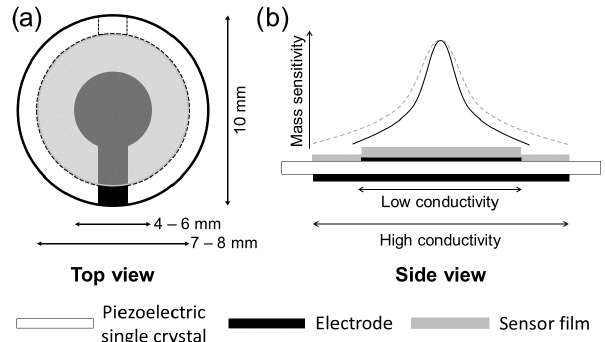
Figure 1. (a) Top view of the resonator layout. (b) Side view of the resonator layout (lower part). At low oxide film conductivity, the electrode radius is determined by the top Pt electrode. At high con- ductivity, the metal oxide acts as an electrode, and the (effective) electrode radius is determined by the oxide film. This inflicts the mass sensitivity (upper part) as well. The maximum mass sensitivity in the centre of the resonator remains mainly unchanged, whereas the lateral distribution follows the larger (effective) electrode radius with increasing oxide film conductivity. For a nearly insulating ox- ide layer, the mass sensitivity distribution is mainly limited to the area of the smaller metal electrode (black solid line). If the oxide film becomes conducting, the mass sensitivity distribution broadens (dashed grey line) and covers the whole oxide